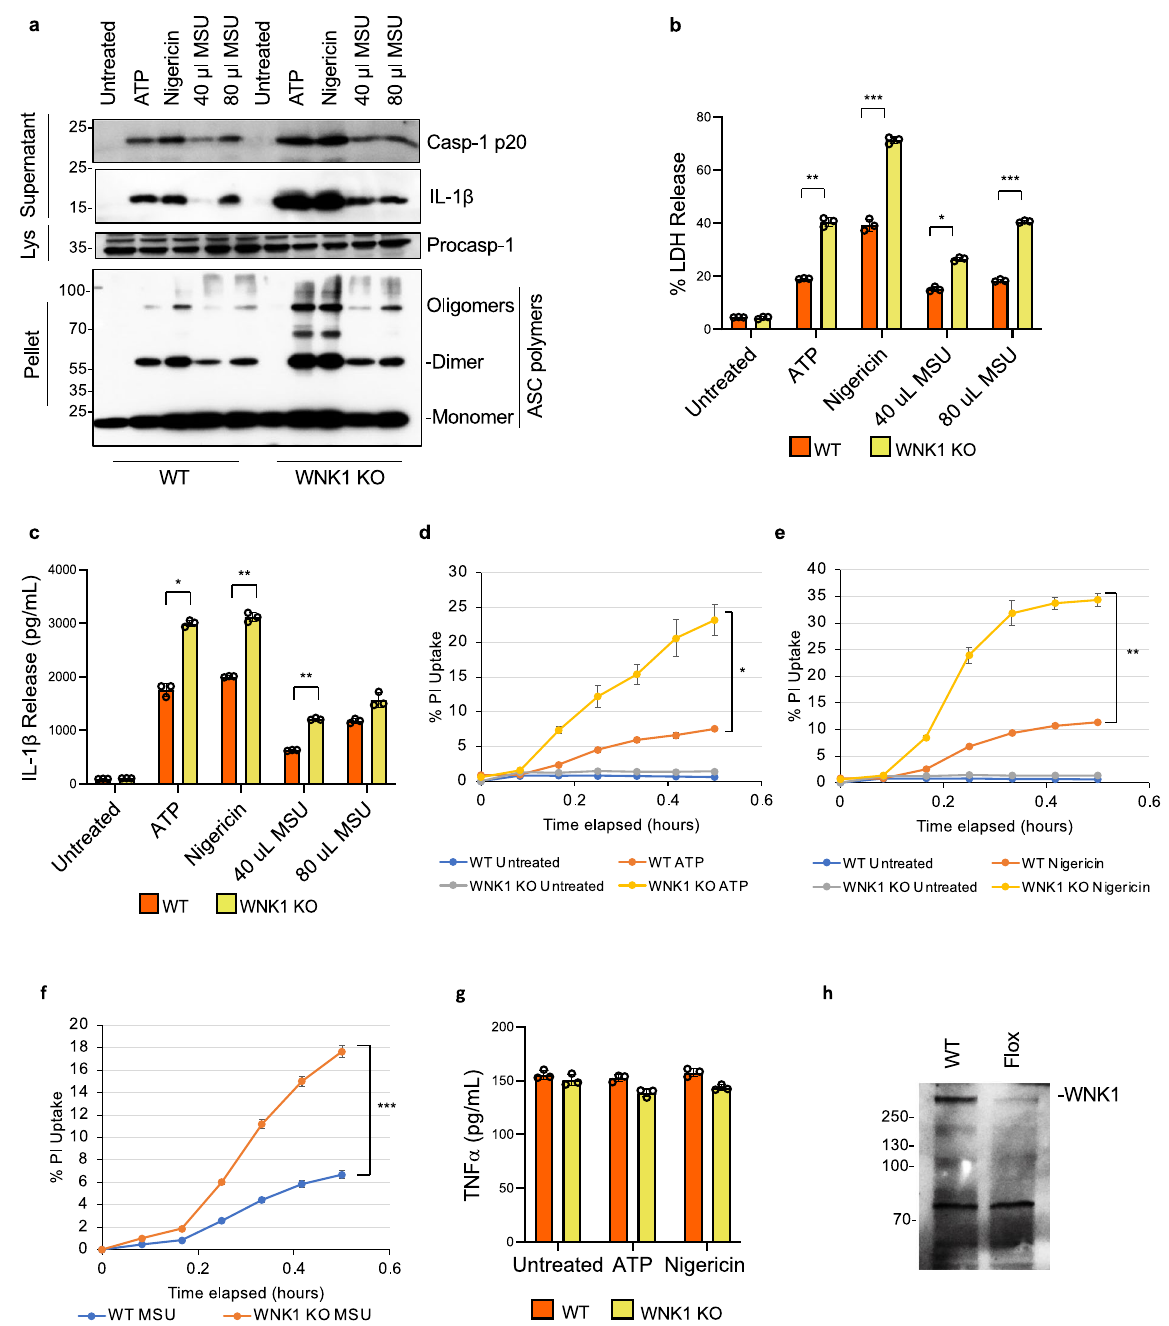
Fig. 3 Conditional WNK1 knockout increases NLPR3 in fl ammasome activation in macrophages. a Immunoblots of caspase-1 p20 and mature IL-1 β released in culture supernatants (Supernatant), procaspase-1 in cell lysates (Lys) or ASC in NP40-insoluble pellets (Pellet) of LPS-primed (4h) primary Wnk1 + / + LysMCre + (WNK1 WT) and Wnk1 fl ox/ fl ox LysMCre + (WNK1 KO) BMDMs treated with ATP (5mM), nigericin (10 µ M), or MSU (40ul or 80ul 5mgml − ) as indicated. LDH ( b ) and IL-1 β ( c ) release in culture supernatants of LPS-primed (4h) primary Wnk1 + / + LysMCre + (WNK1 WT) and Wnk1 fl ox/ fl ox LysMCre + (WNK1 KO) BMDMs treated with ATP, nigericin, or MSU (40ul or 80ul 5mgml − MSU) as indicated. P values of b are 0.6525, 0.00177,0.00044, 0.00618, and 0.00017; c are 0.0536, 0.00595, 0.0026, 0.0008, and 0.0602. Propidium iodide uptake of LPS-primed (4h) primary Wnk1 + / + LysMCre + (WNK1 WT) and Wnk1 fl ox/ fl ox LysMCre + (WNK1 KO) BMDMs treated with ATP ( d ), nigericin ( e ), or MSU ( f ). P value of d is 0.0072; e is 0.00065; f is 0.00004. g TNF α release in culture supernatants of LPS-primed (4h) primary Wnk1 + / + LysMCre + (WNK1 WT) and Wnk1 fl ox/ fl ox LysMCre + (WNK1 KO) BMDMs treated with ATP or nigericin. h Immunoblot of WNK1 in cell lysates of Wnk1 + / + LysMCre + (WNK1 WT) and Wnk1 fl ox/ fl ox LysMCre + (WNK1 KO) BMDMs. Results are representative of at least three independent experiments performed in duplicate or triplicate. Error bars in b – g are presented as mean values±standard deviation (S.D.), with n = 3. Two-sided Student ’ s t test, * p <0.05, ** p <0.005, *** p